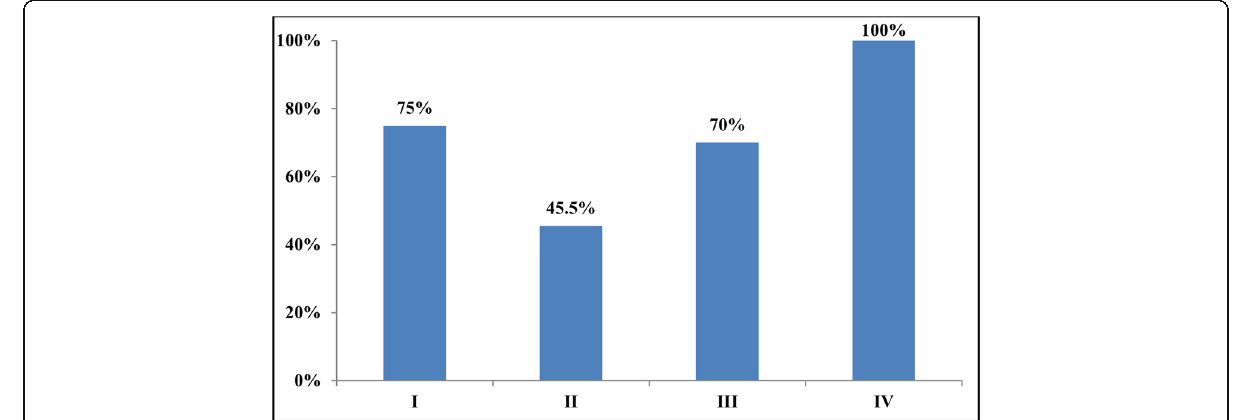
Fig. 8 The occurrence of violations in relation to tumor